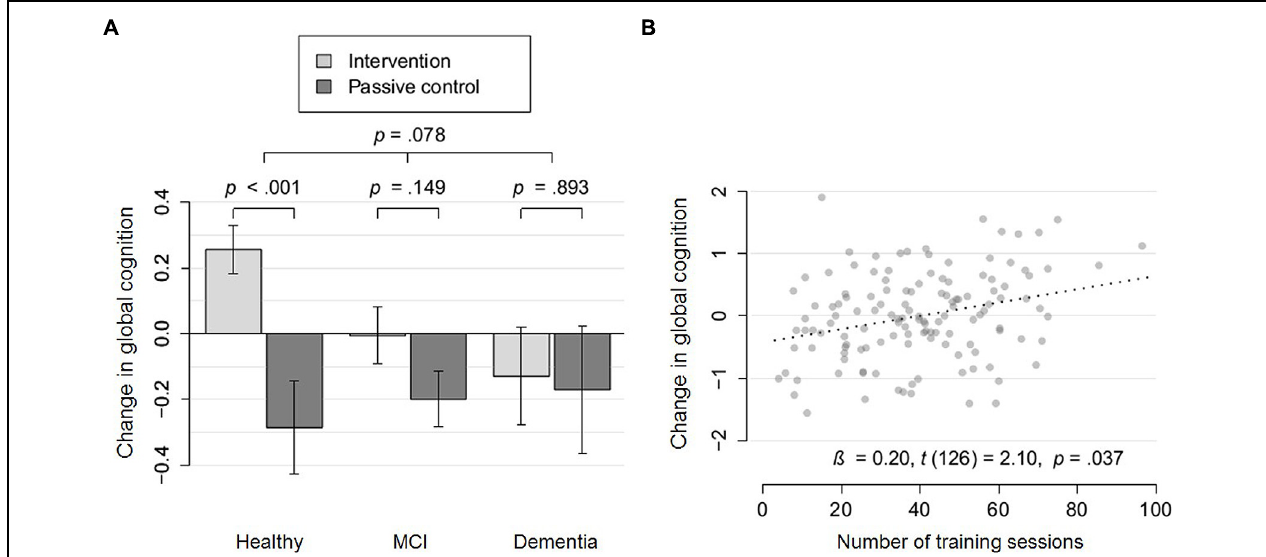
FIGURE 3 | Moderation and dose-response effects for global cognition. (A) Change in global cognition (partial residuals accounting for covariates) of the intervention group (light gray), compared to the passive control group (dark gray) within cognitively healthy participants, participants with mild cognitive